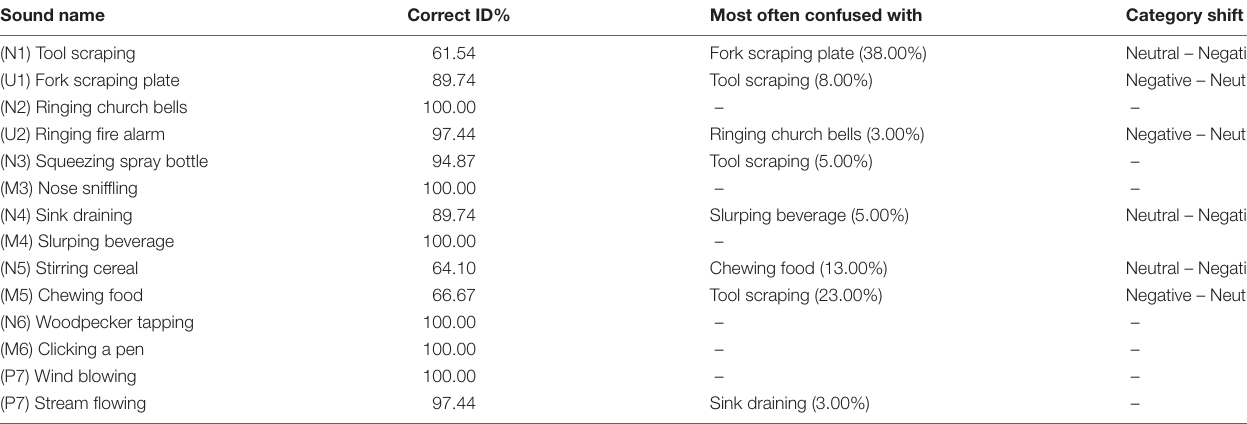
TABLE 4 | Percentage of correct identification for each sound token and the sound (if applicable) it was most confused with across all participants in Experiment